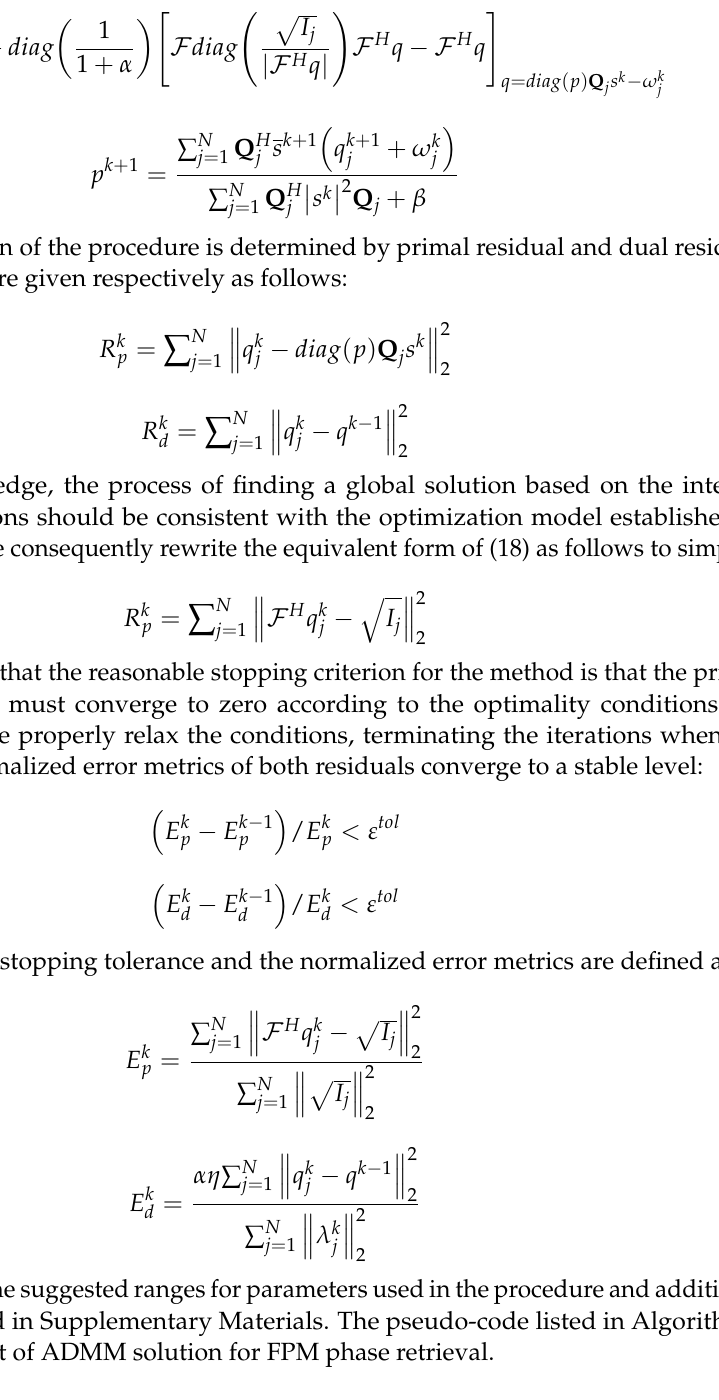
Table 2. Suggested parameter ranges for ADMM-FPM